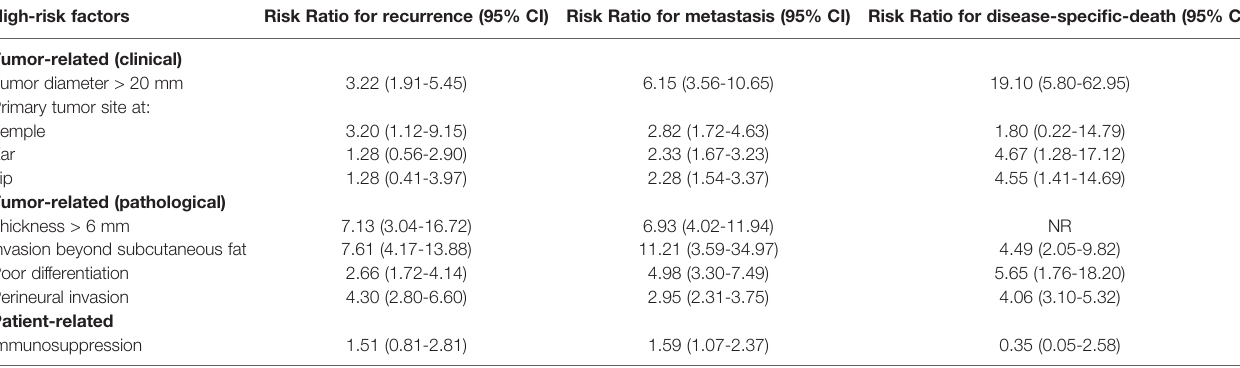
TABLE 1 | Risk ratios for recurrence, metastasis, and disease-speci fi c death for some of the most relevant high-risk factors (22). High-risk